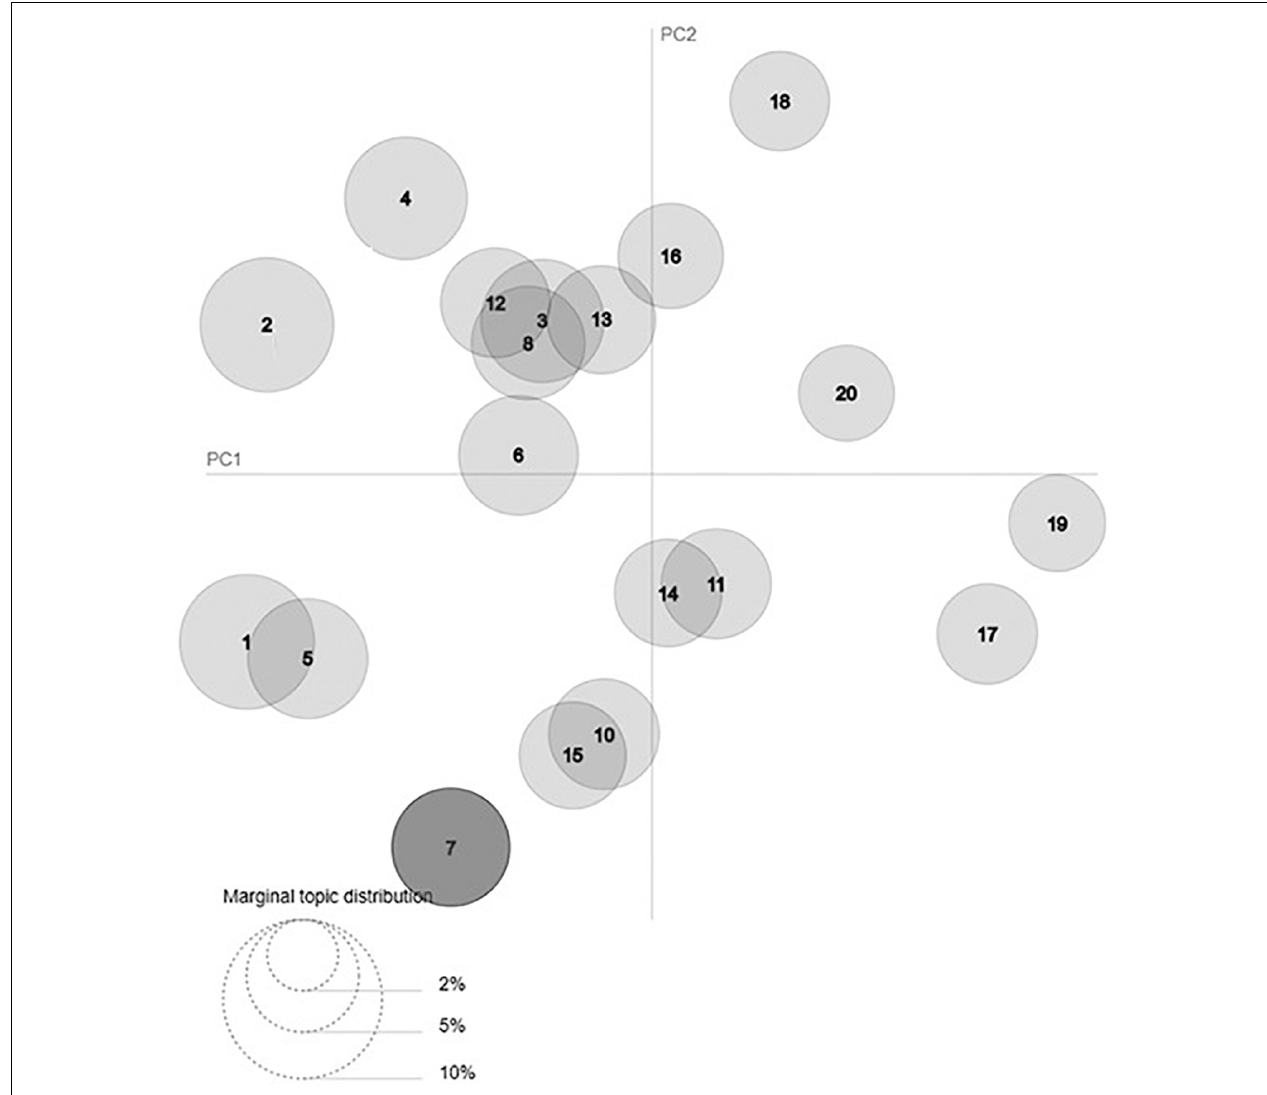
FIGURE 7 | Visualization of intertopic distance